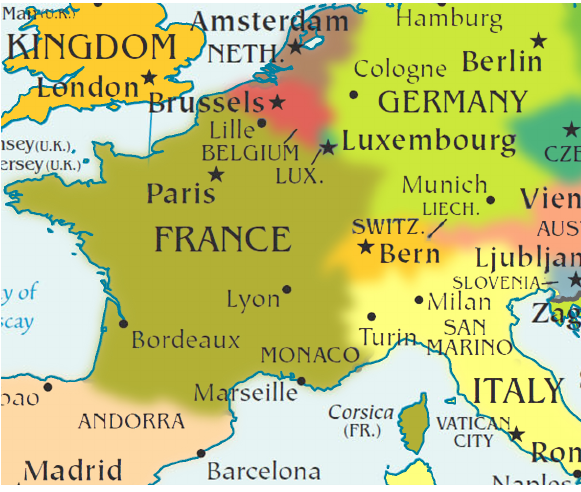
Figure 12: CIA map revisited: Schengenland